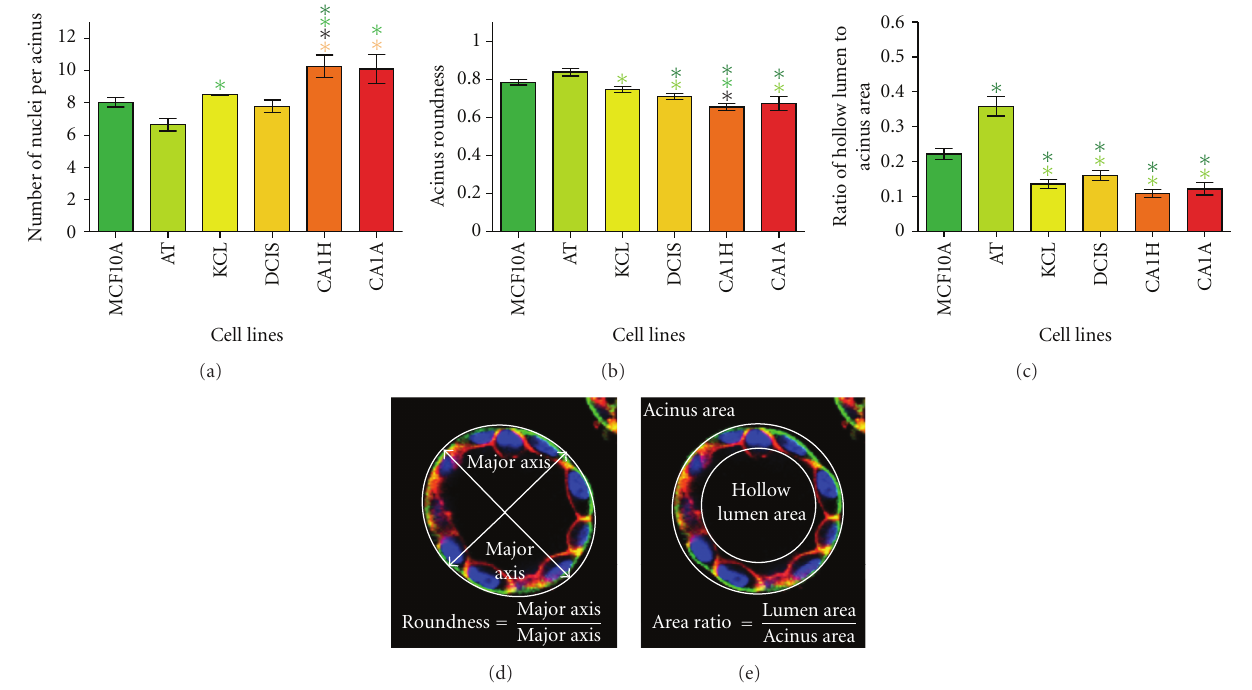
Figure 4: Features quantifying acinus and hollow lumens morphology are statistically significant between cell lines and states of health. (a) shows the number of nuclei per acinar structure, (b) shows the acinar structure elongation (roundness) that is measured as illustrated in (d) where the ratio between the minor and major axis of the ellipse fitted to the acinar structure is taken, and (c) shows the ratio between the hollow lumen and acinar structure areas that is computed as illustrated in (e). Error bars correspond to the standard error of the means. Two-sided t -tests were performed and cell lines that exhibit statistically significance ( P < 0 . 05) are marked with asterisks ( ∗